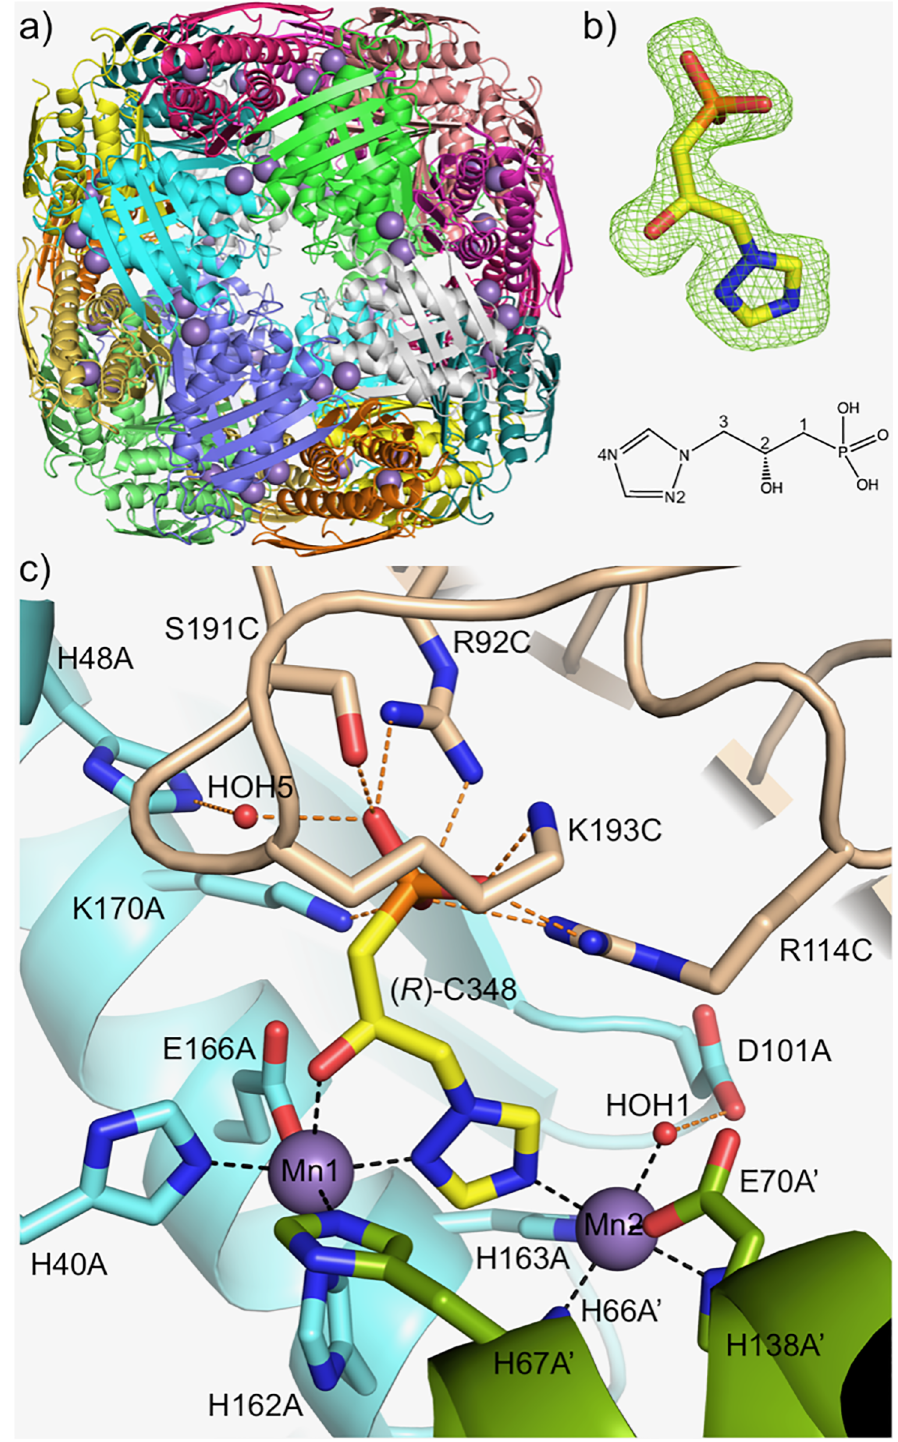
Fig 3. Crystal structure of Acanthamoeba IGPD complex. The crystal structure of Ac _IGPD in complex with ( R )- C348. (a) The 24mer structure of Ac _IGPD viewed down one of the 4-fold axes. The protein backbone is shown as a cartoon coloured by chain and the two manganese(II) ions, positioned in each of the active sites, are drawn as purple spheres. (b) A representative Fo-Fc difference omit map for one molecule of ( R )-C348 (C = yellow, O = red, N = blue, P = orange) is shown as a green mesh (contoured at 3 σ) (An NCS averaged omit map for the binding site is shown